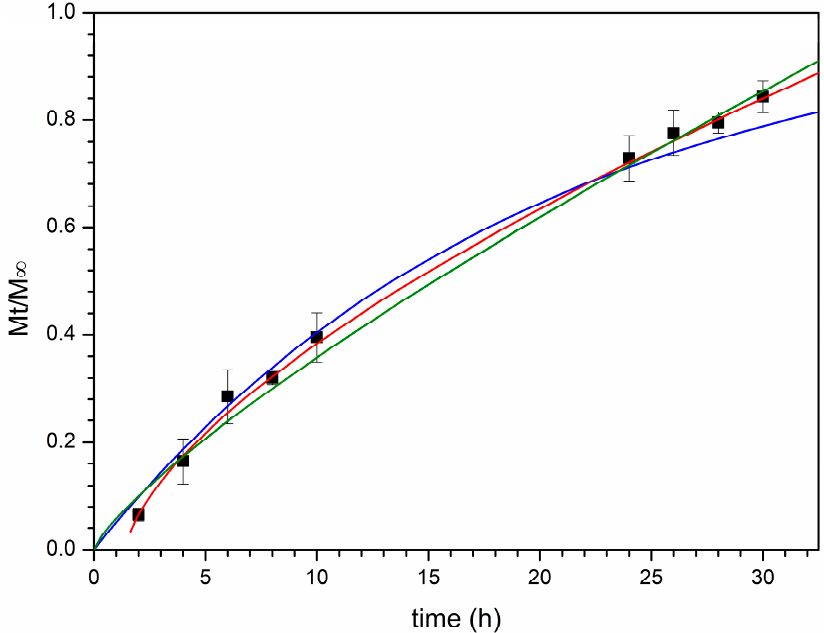
Figure 9. QRC dose fraction released from BioQ-CPX ( (cid:4) ) as a function of incubation time, curve-fitted with the First Order (blue line), Korsmeyer–Peppas (green line), and Korsmeyer–Peppas with T lag (red line) mathematical models; means ± SE ( n = 6).